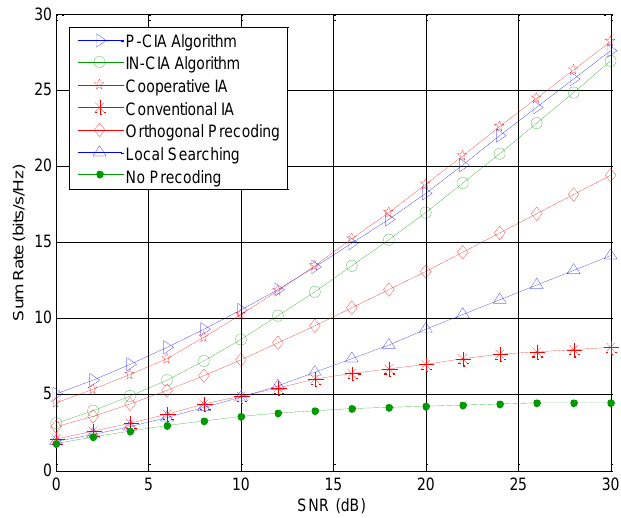
Figure 2. Sum rate comparison of the Internet of Things (IoT) oriented femtocell with existing precoding algorithms.